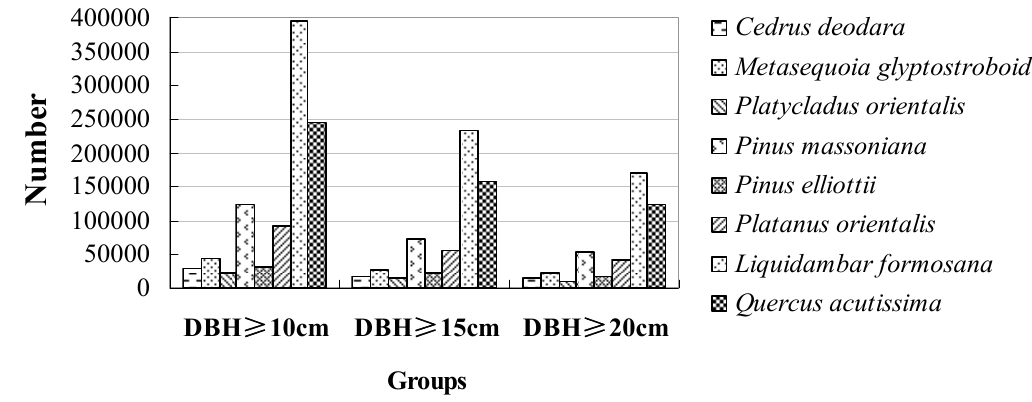
Figure 9. Tree count of different species at Purple